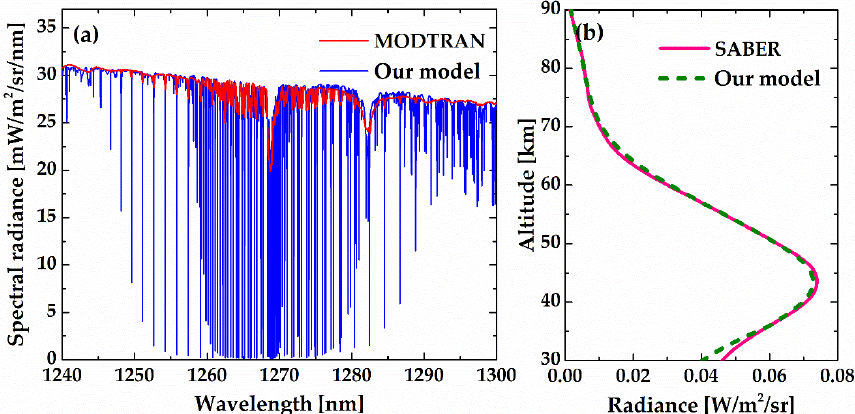
Figure 16. Comparisons between the emission–absorption transfer model and results from MODTRAN4 and the TIMED–SABER measurements. ( a ) Calculated spectral radiance using our model and MODTRAN4 at tangent height of 20 km. ( b ) Measured and modeled O 2 (a 1 Δ g ) band brightness as a function of tangent height.